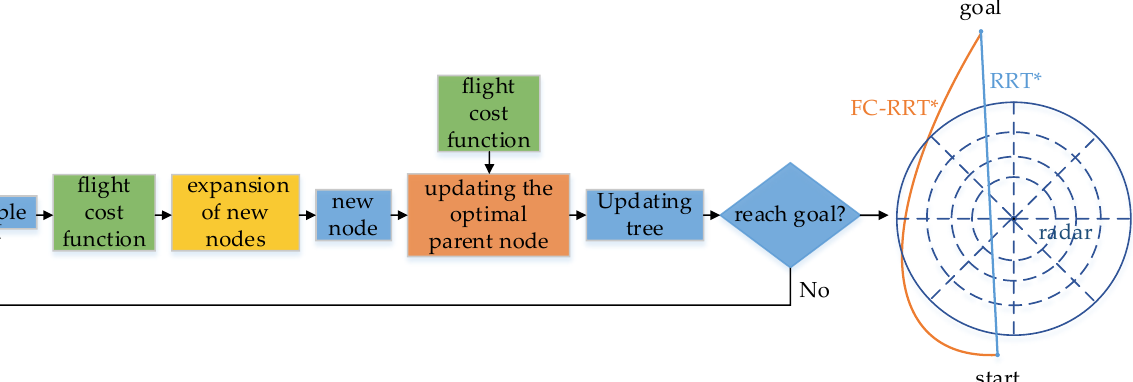
Figure 1. Flowchart and result diagram of FC-RRT * algorithm. In the figure, the green box represents contribution 1, the yellow box represents contribution 2, and the orange box represents contribution 3. It can be seen in the result diagram that the algorithm in this paper can obtain a path with higher path safety for radar and other threat areas than RRT* can.